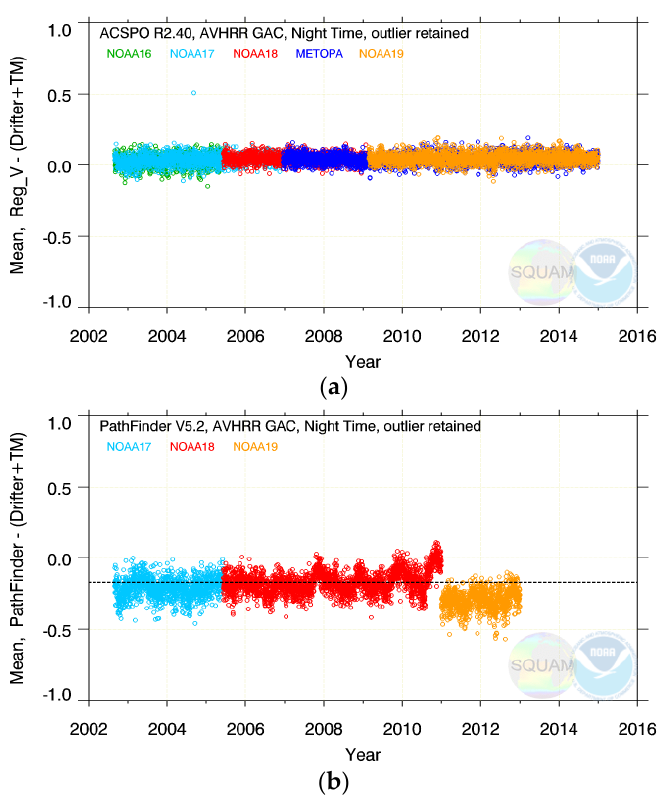
Figure 3. Mean nighttime biases Δ T S = T S − T in situ in: ( a ) RAN1; ( b ) Pathfinder version 5.2 (PFV5.2) for the time period covered by RAN1. (The PFV5.2 reports “skin” SST, obtained by subtracting − 0.17 K from the “bulk” SST tuned to buys. The expected − 0.17 K bias is shown with the dotted line). RAN1 SSTs are more stable in time and cross-platform consistent, with typical biases of ~0 ± 0.1 K, compared with − 0.17 ± 0.25 K in PFV5.2. The regression coe ffi cients in both datasets are trained against buoys, but in PFV5.2, a − 0.17 K is subtracted, to obtain the “skin” SST product [8]. Comparing Figure